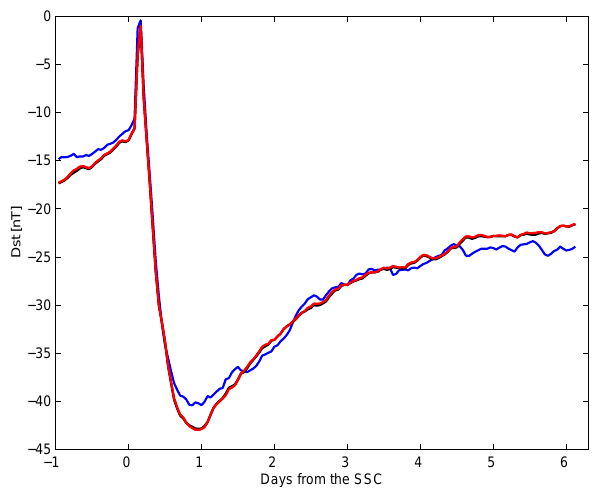
Fig. 8. Superposed epoch storm curves using the reconstructed D st in 1932–1956 (blue) and 1957–2002 (red). The curve using the original D st (black) in 1957–2002 is depicted under the red